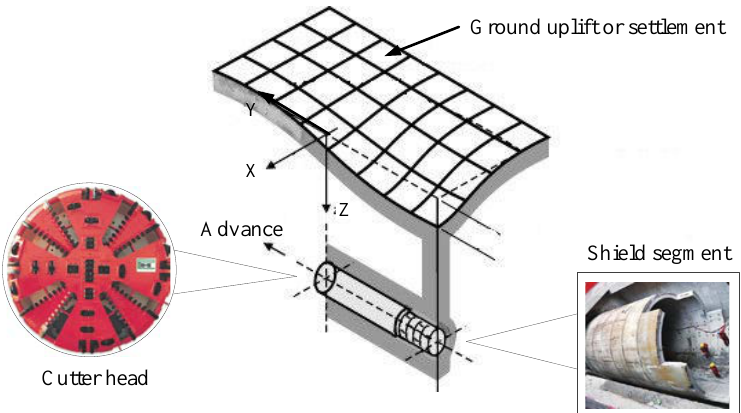
Figure 1. The diagram of shield tunneling in